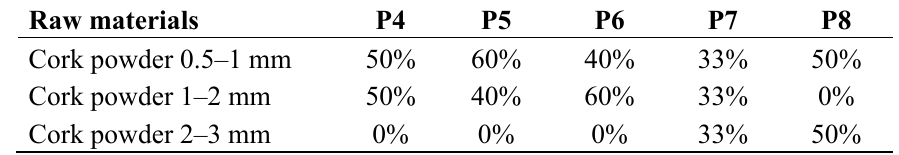
Table 2. Pelletizing assays in waste